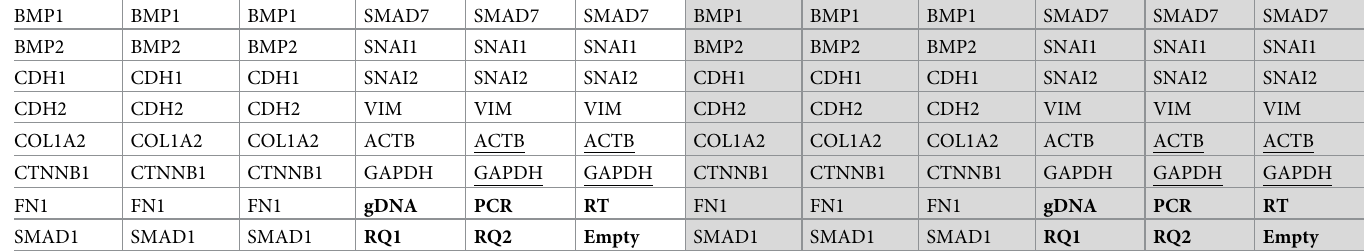
Table 4. Prime PCR custom 96-well plate design for two different samples (white or grey background). Control assays are in bold, and reference genes are